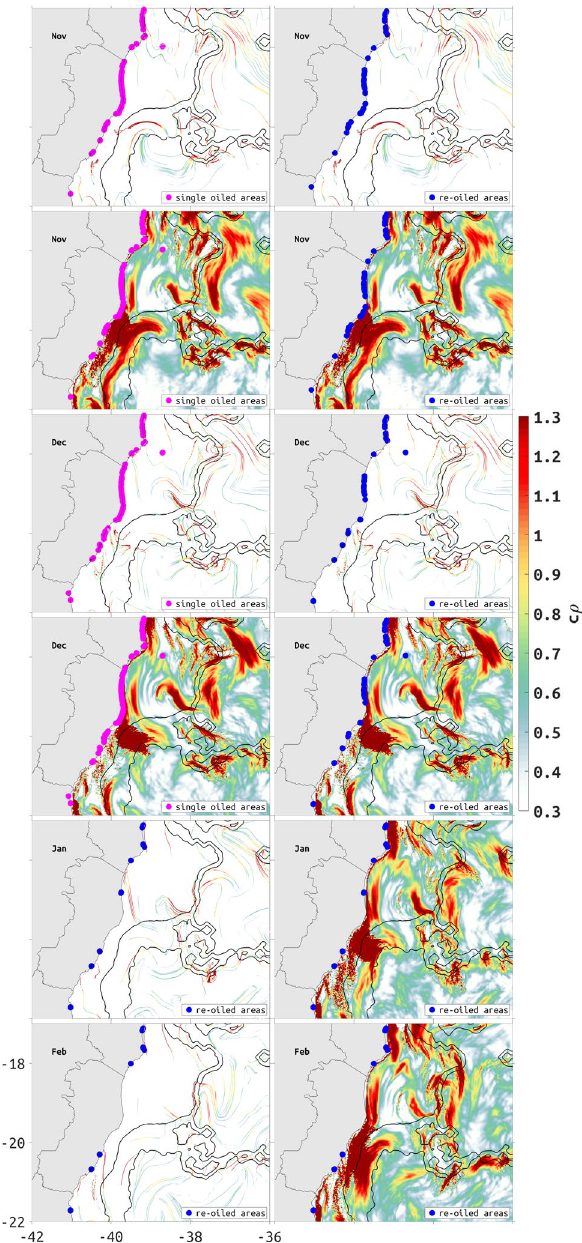
Figure 10. Location of beaches along the Brazilian coast within the study area that were oiled for the first time (pink dots) and that were re-oiled (blue dots) in November ( a – d ) and December ( e – h ) of 2019, and January ( i – j ) and February ( k – l ) of 2020. Depth contours of 200- and 2000-m are represented by thin black lines. Oiled sites are superposed to monthly mean cLCS (colored lines) and c ρ (color shading) to indicate transport patterns and particle attraction sites. Created with Matlab R2018B (www.mathw